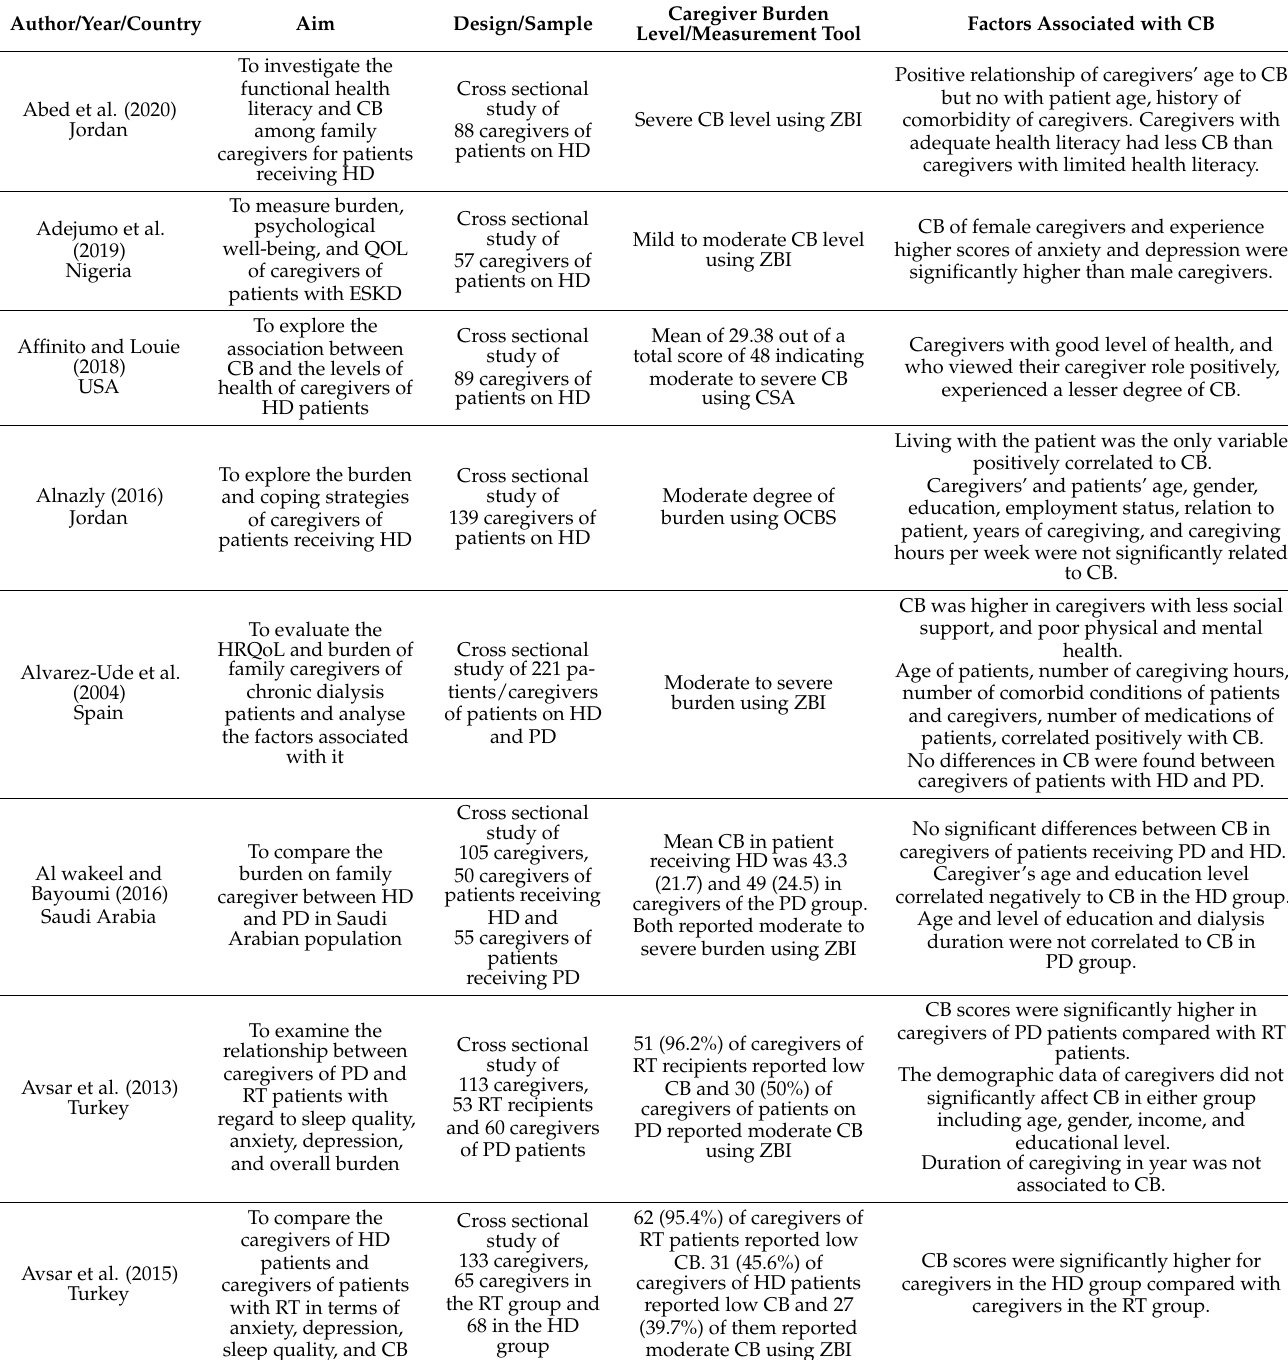
Table 1. Summary of the included